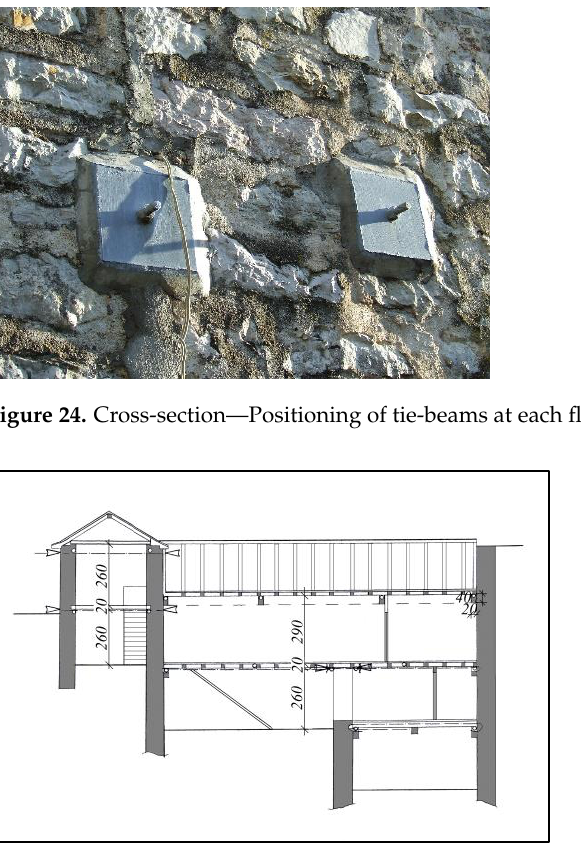
Figure 25. Cross-section—Positioning of tie-beams at each floor level. Figure 25. Version with interior ring beam fixed at the positions that suffered severe